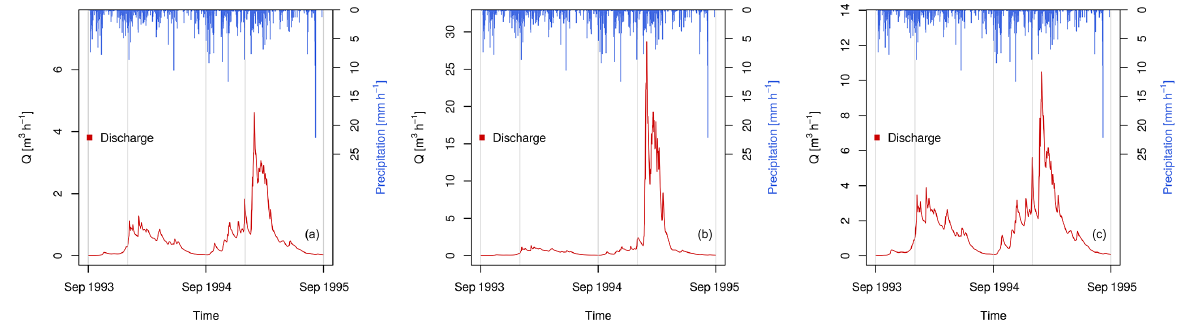
Figure 11. Simulated sewer discharge due to soil water infiltration (m − 3 h − 1 ) during the first simulation period 1993–1995 based on the combination of parameters I p set at 0.09 and I rd set at 10 − 5 and (a) D ∗ limited to 2%, (b) D ∗ limited to 1% and (c) based on the combination of parameters I p set at 0.3 and I rd set at 10 − 5 , with a D ∗ value limited to